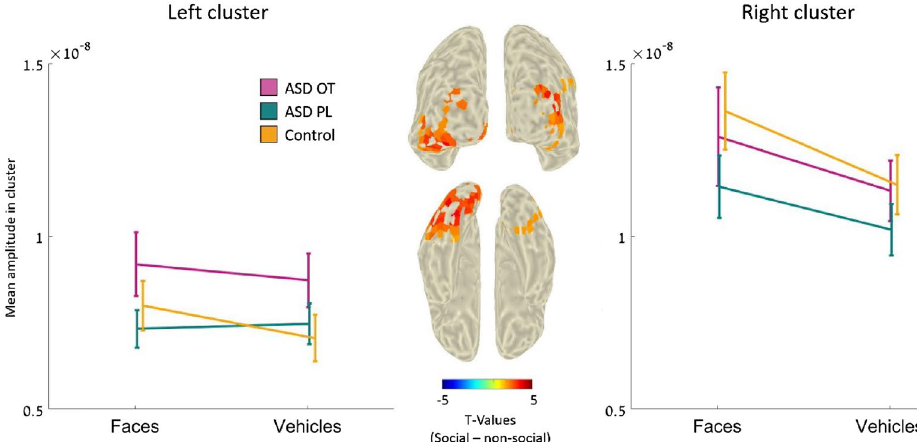
Figure 5. Neural activity in typical social-related ROIs of the experimental groups. These ROIs were pooled from the M170 time windows of the TD group. In this period, higher neural activity was observed in response to social stimuli than non-social stimuli. The middle section shows posterior and bottom views of social-related ROIs in the TD study. Color coding represents t-values. These regions represent neural regions that were more active in social trials than in non-social trials. The left and right panels show the average neural activity in these clusters (left and right, respectively) in each group separately.